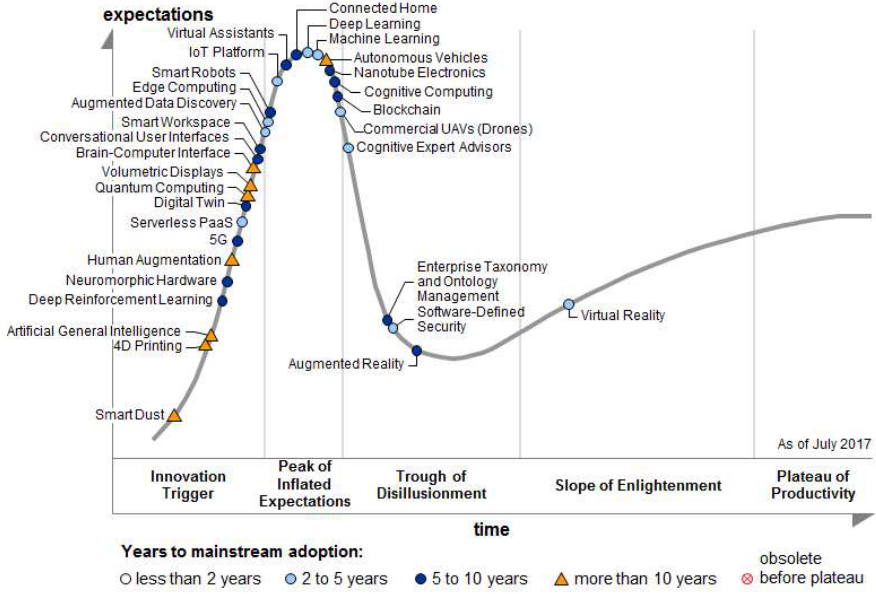
Figure 7. Gartner Hype Cycle, July 2017 [33].